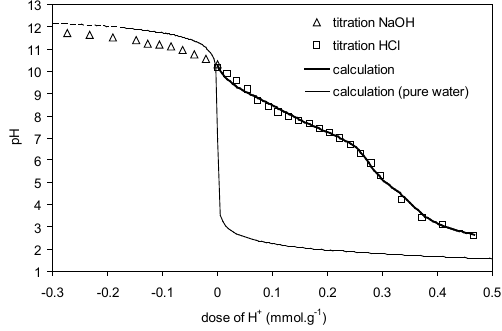
Figure 2. Titration curve of activated carbon K835 in aqueous suspension; Curve in acidic solution is interpolated by calculation in the system GWB. For comparison, the curve for water without the carbon is also presented (values on X-axis are relative to the same theoretical dose of carbon to make curves directly